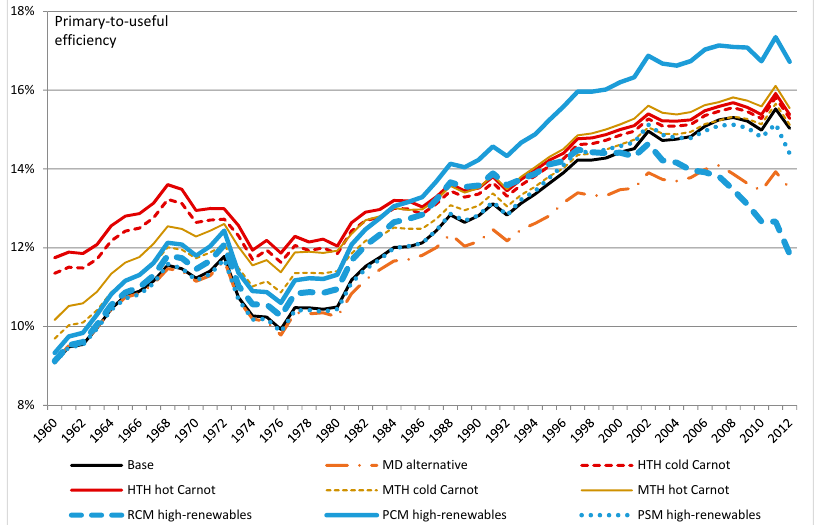
Figure 14. National primary-to-useful exergy efficiency estimates using each methodological approach, including high-renewables scenarios. Primary exergy for end-use efficiency methods is calculated using the physical content method, and useful exergy for the high-renewables scenarios is calculated using the base end-use efficiency methods (RCM = Resource Content Method, PCM = Physical Content Method, PSM = Partial Substitution